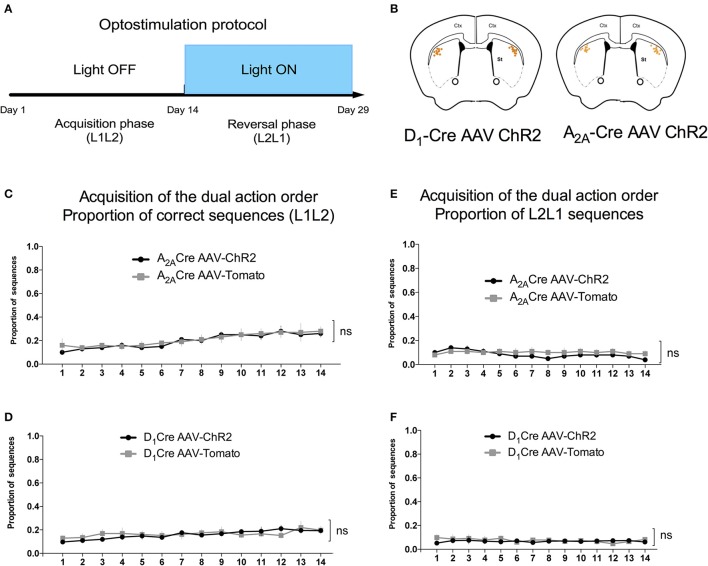
Acquisition phase of the dual action order is not influenced by viral injection. (A) Timeline containing the optogenetic activation protocol and (B) schematic figure showing the cannulaes and fiber position in the mice DLS. The proportion of correct sequences is not influenced by viral injection in both, iMSNs (C), or dMSNs (D). Similarly the viral injection does not affect the proportion of L2L1 incorrect sequence in iMSNs (E) or dMSNs (F). The data are mean ± SEM of n = 7–12 mice per group.